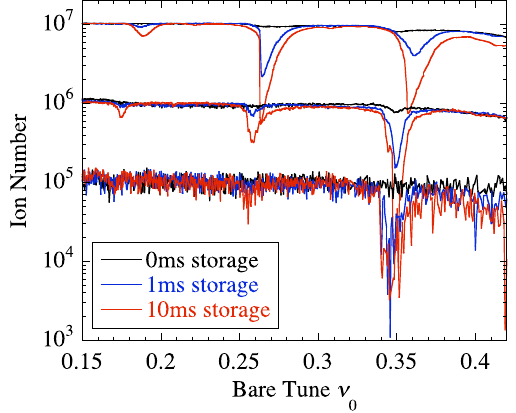
FIG. 8. Stop-band distributions measured by the S-POD sys- tem. The ordinate is the number of Ar ions surviving after a short storage in the LPT at a certain bare tune (cid:5) 0 . The storage periods considered in these experiments are 0 ms (immediate extraction; black), 1 ms (blue), and 10 ms (red). The noises in the low- density experiments ( N in (cid:3) 10 5 ) are due simply to the limited signal-to-noise ratio of the Faraday cup.